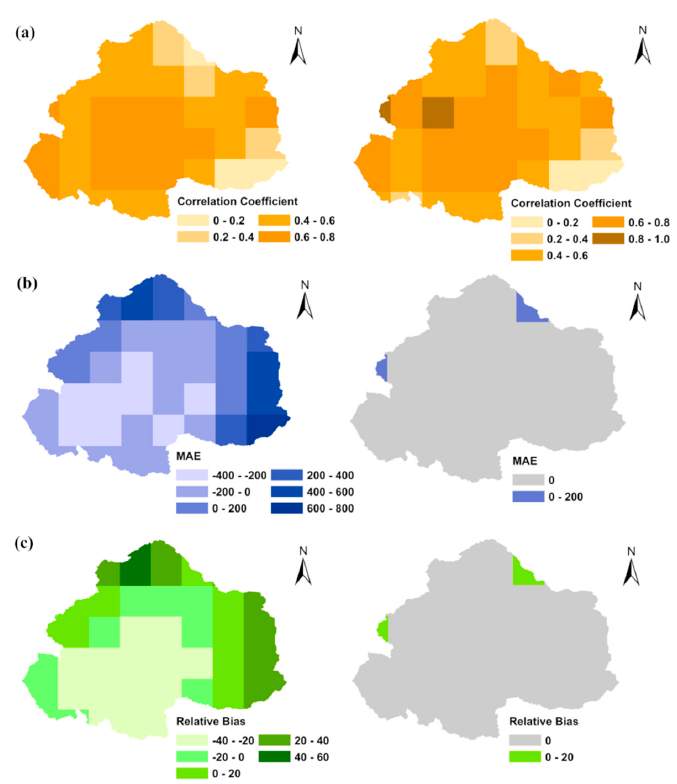
Figure 10. Spatial plot of performance evaluation parameters namely ( a ) correlation coefficient ( r ) ( b ) MAE and ( c ) RBIAS, before (left) and after (right) bias correction of TRMM precipitation for the monsoon season.